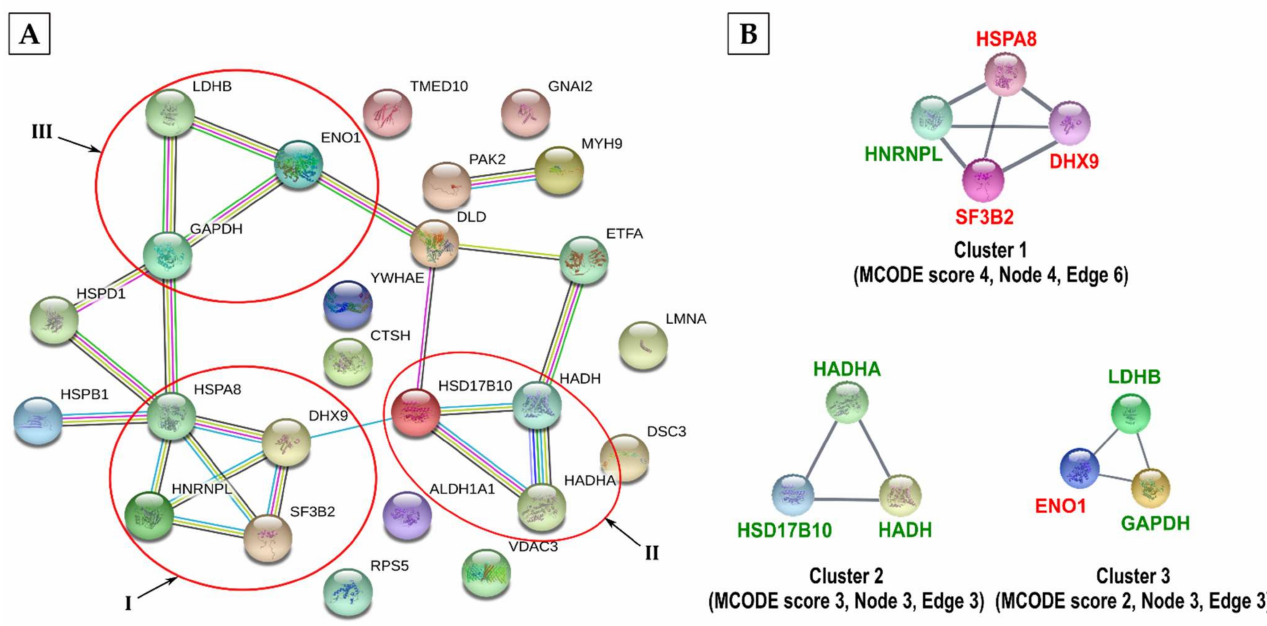
Figure 8. STRING functional protein association network of allysine host proteins. ( A ) The identified allysine host proteins from infected cells were analysed for functional protein association using the STRING database. Proteins are shown as nodes while interactions are shown as edges. The association network contains 22 edges and 25 nodes with an average node degree of 1.76. The minimum required interaction score was set to high confidence ( ≥ 0.700) and PPI enrichment p -value was <3.2 × 10 − 6 . Major clusters are encircled in red. ( B ) The three most highly ranked and tightly connected protein clusters were obtained by the MCODE algorithm using Cytoscape. The clusters were ranked based on their MCODE scores. The proteins shown in red are known to be involved in influenza virus